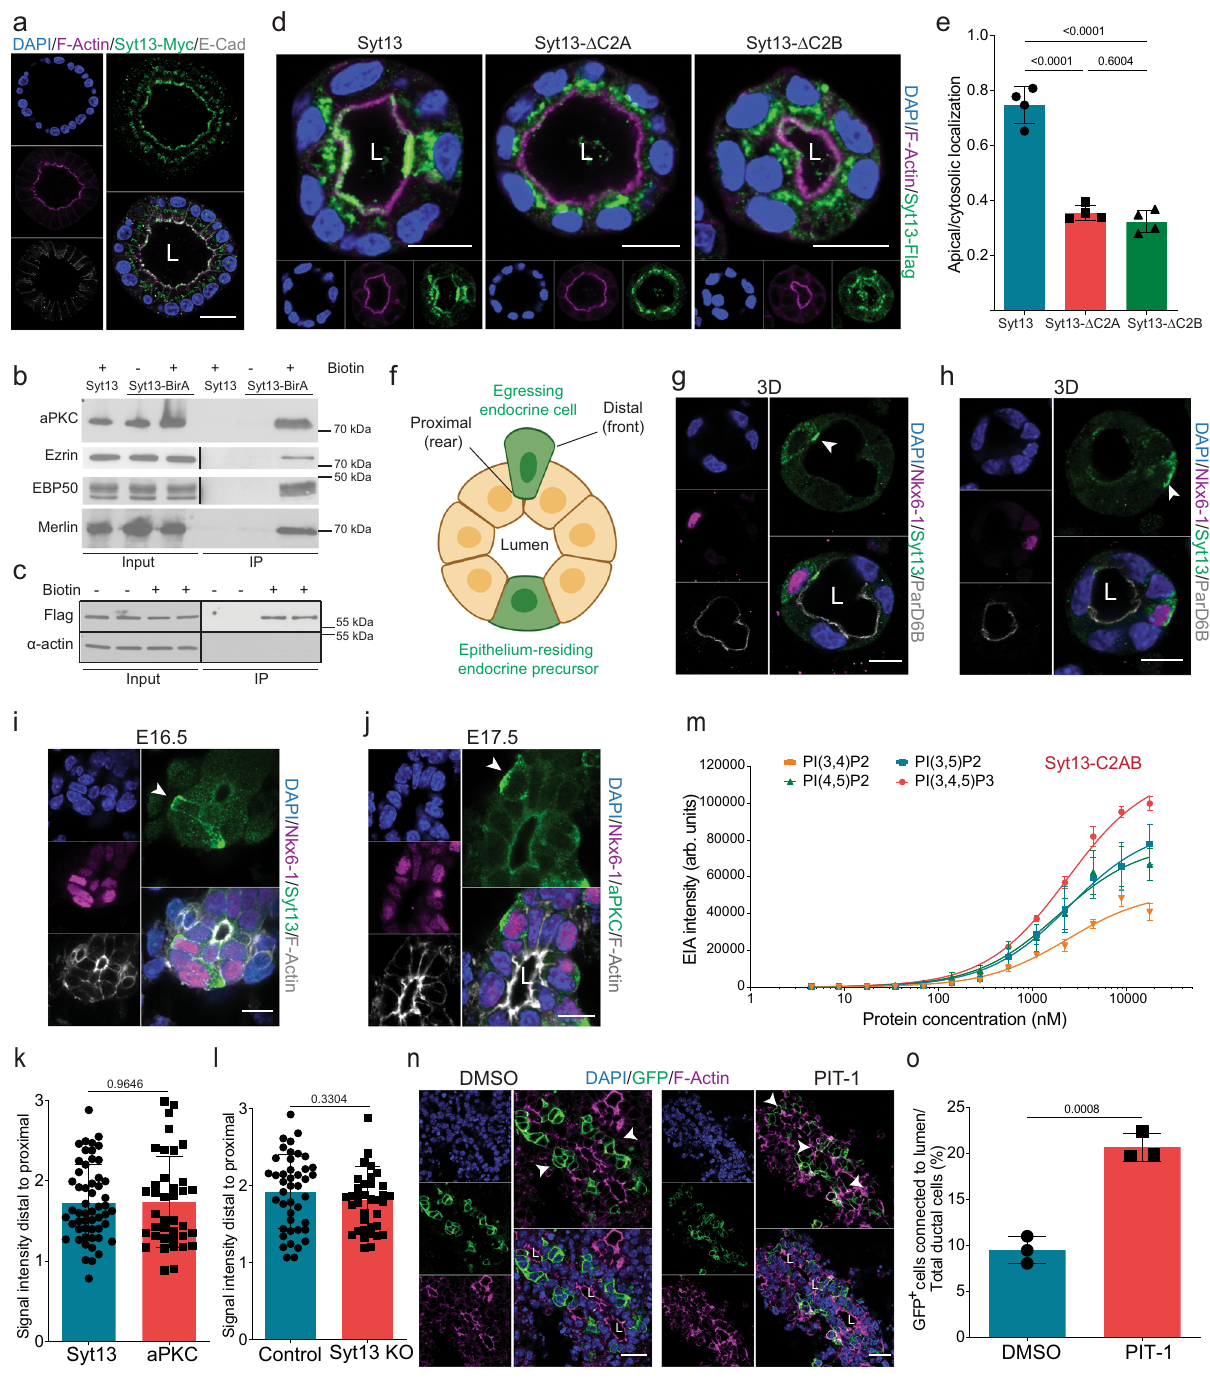
(Glu-tub). These post-translational modi fi cations (PTMs) of tubulin in fl uence the stability and dynamics of the MT cytoskeleton 31 . Using the scRNA-seq data, we evaluated expres- sion levels of the enzymes involved in tubulin PTM, indicating increased transcripts of α -tubulin N-acetyltransferase 1 (Atat1) and tubulin polyglutamylase (Ttll7) in Ngn3 high precursors. In contrast, mRNA levels of Svbp , which is involved in α -tubulin detyrosination, were reduced (Fig. S8d). In agreement with the gene expression data, we also detected a signi fi cant increase in Tyr-tub and Ac-tub protein content in Syt13-expressing cells (Fig. 5g – i).